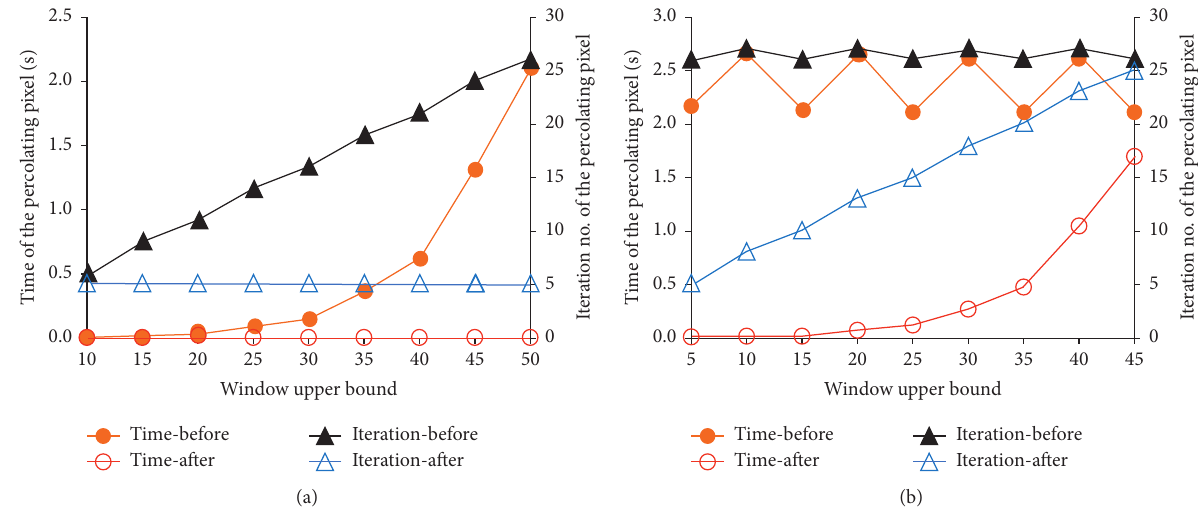
Figure 11: The effect of changing parameters on time and iterations of percolation on the single pixel: (a) window upper bound; (b) window lower bound.